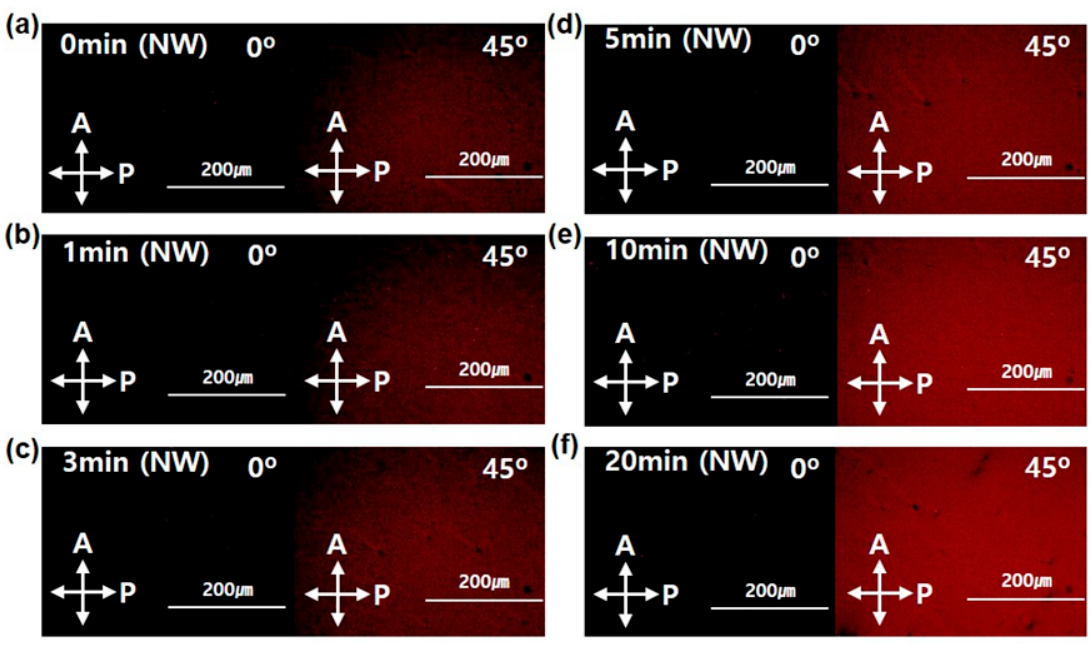
Figure 4. Polarized optical microscopy (POM) images of P3HT-NW films annealed by CF vapor for different times: ( a ) 0, ( b ) 1, ( c ) 3, ( d ) 5, ( e ) 10, and ( f ) 20 min.